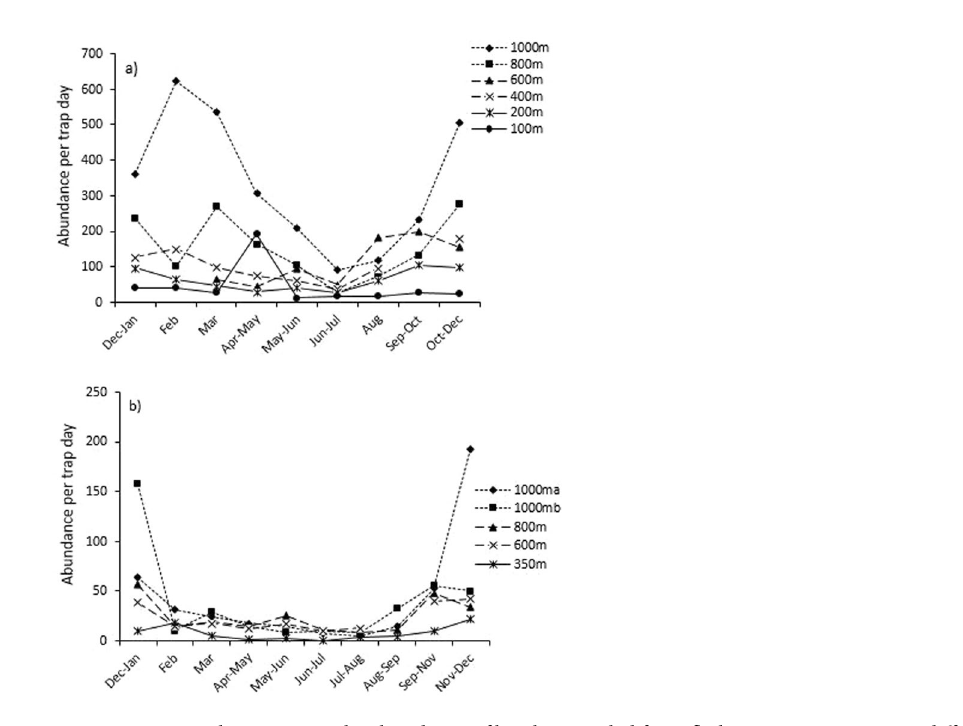
Figure 3. Seasonal variation in the abundance of beetles sampled from flight interception traps at different sites on the Atherton transect ( a ) and the Paluma transect ( b ) in Queensland’s Wet Tropics between December 2006 and January 2008. Samples were standardised to numbers of beetles per trap day to account for slightly uneven temporal sampling periods. Note that the temporal axes are not to